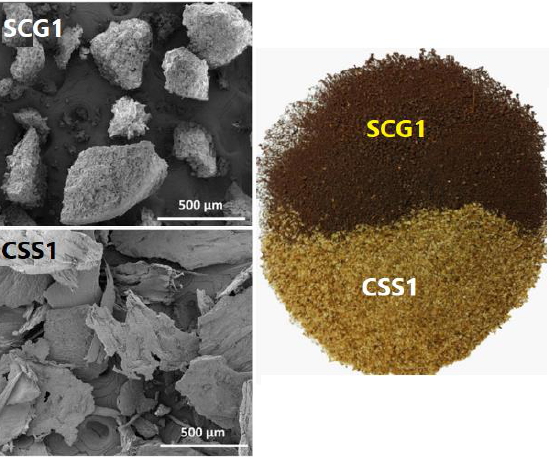
Figure 2. Pictorial view and SEM of coffee silverskin (CSS1 - bottom) and spent ground coffee (SCG1 - top) Source: [10].